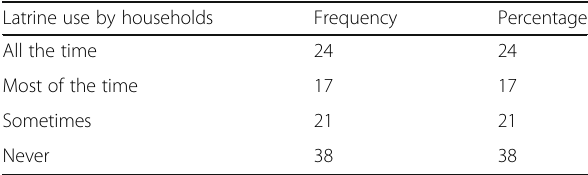
Table 3 Sanitation practices among households Latrine use by households